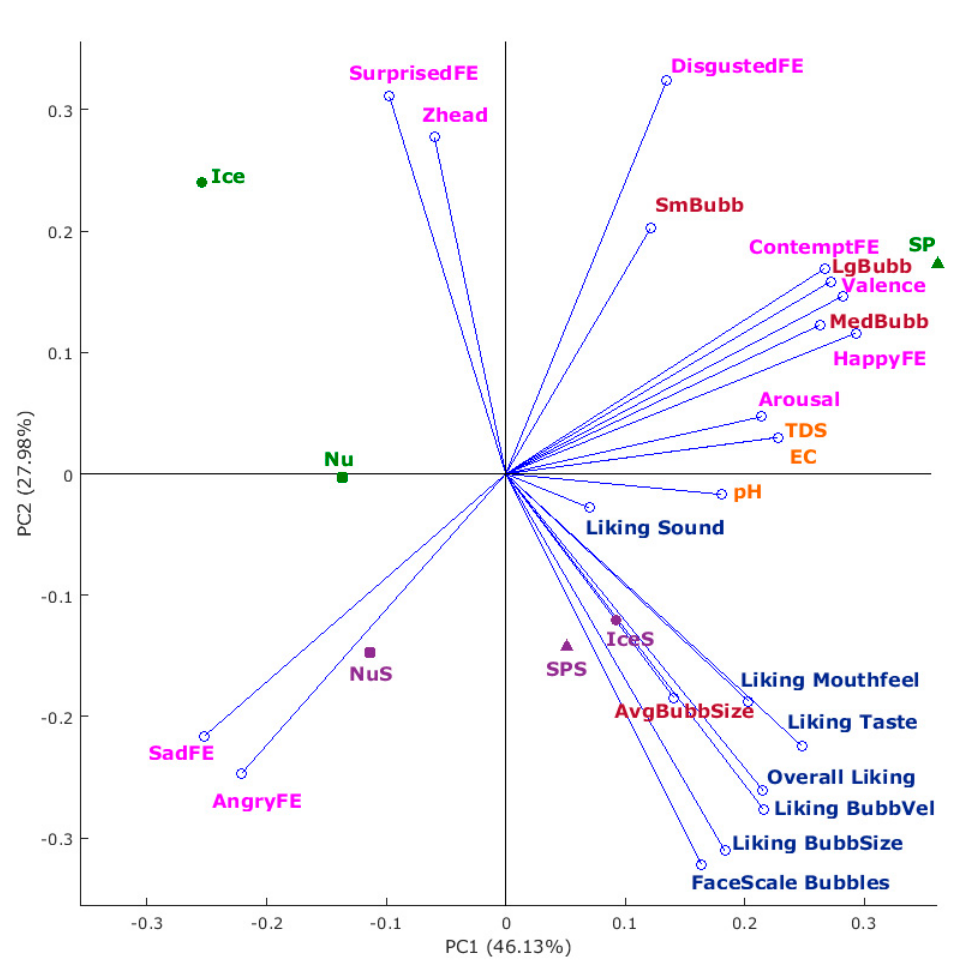
Figure 8. Biplot of the principal component analysis using all sensory, physicochemical, and facial expression responses. Abbreviations: PC = principal component, FE at the end of emotions = facial expression, SmBubb = number of small bubbles, MedBubb = number of medium bubbles, LgBubb = number of large bubbles, TDS = total dissolved solids, EC = electrical conductivity, BubbVel = bubble velocity, BubbSize = bubble size, AvgBubbSize = average bubble size and ZHead = head orientation in z -axis. Table 1 describes the abbreviations of each sample.